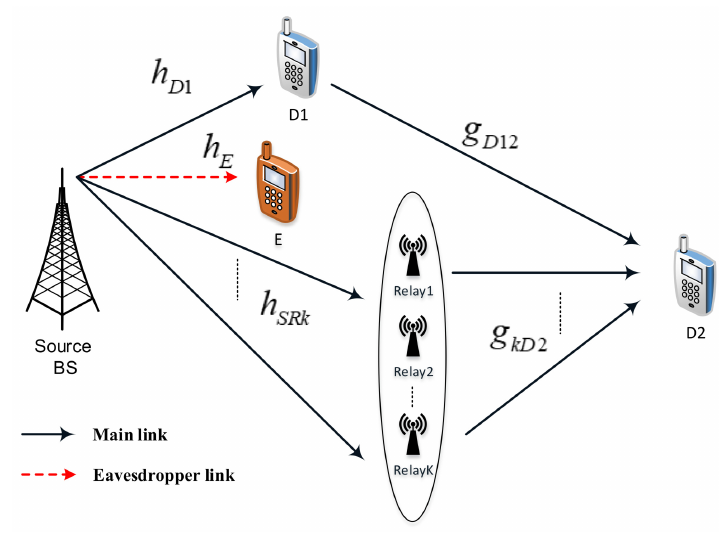
Figure 1. System model of a RS-NOMA assisted IoT system in the existence of an external